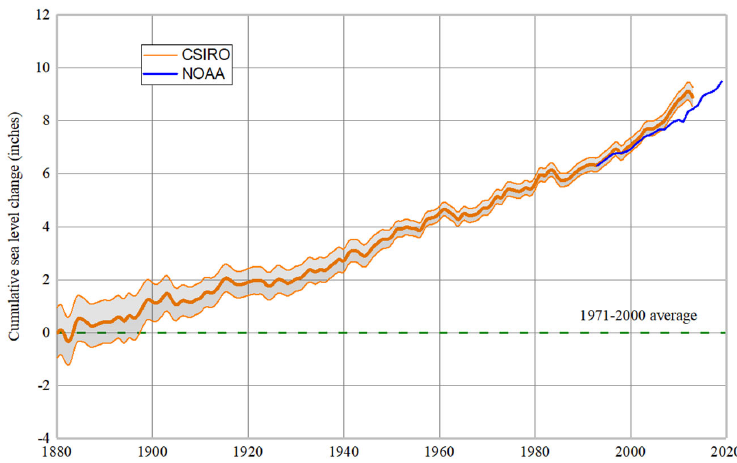
Figure 2. Global absolute sea ‐ level change, 1880–2019.